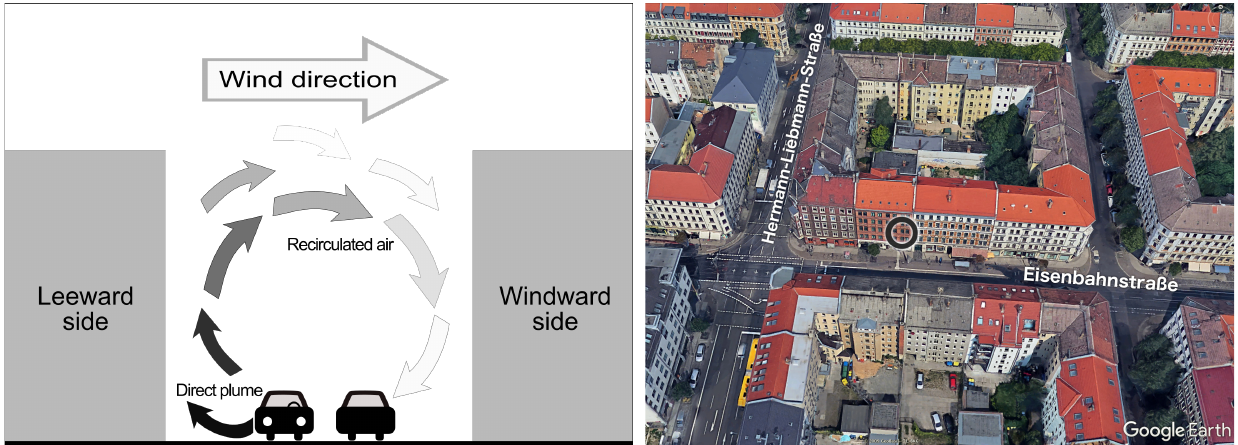
Figure 1. Left: Scheme of a street canyon with indicated vortex. Right: North-oriented GoogleEarth(c) picture of the street canyon with marked station Eisenbahnstraße